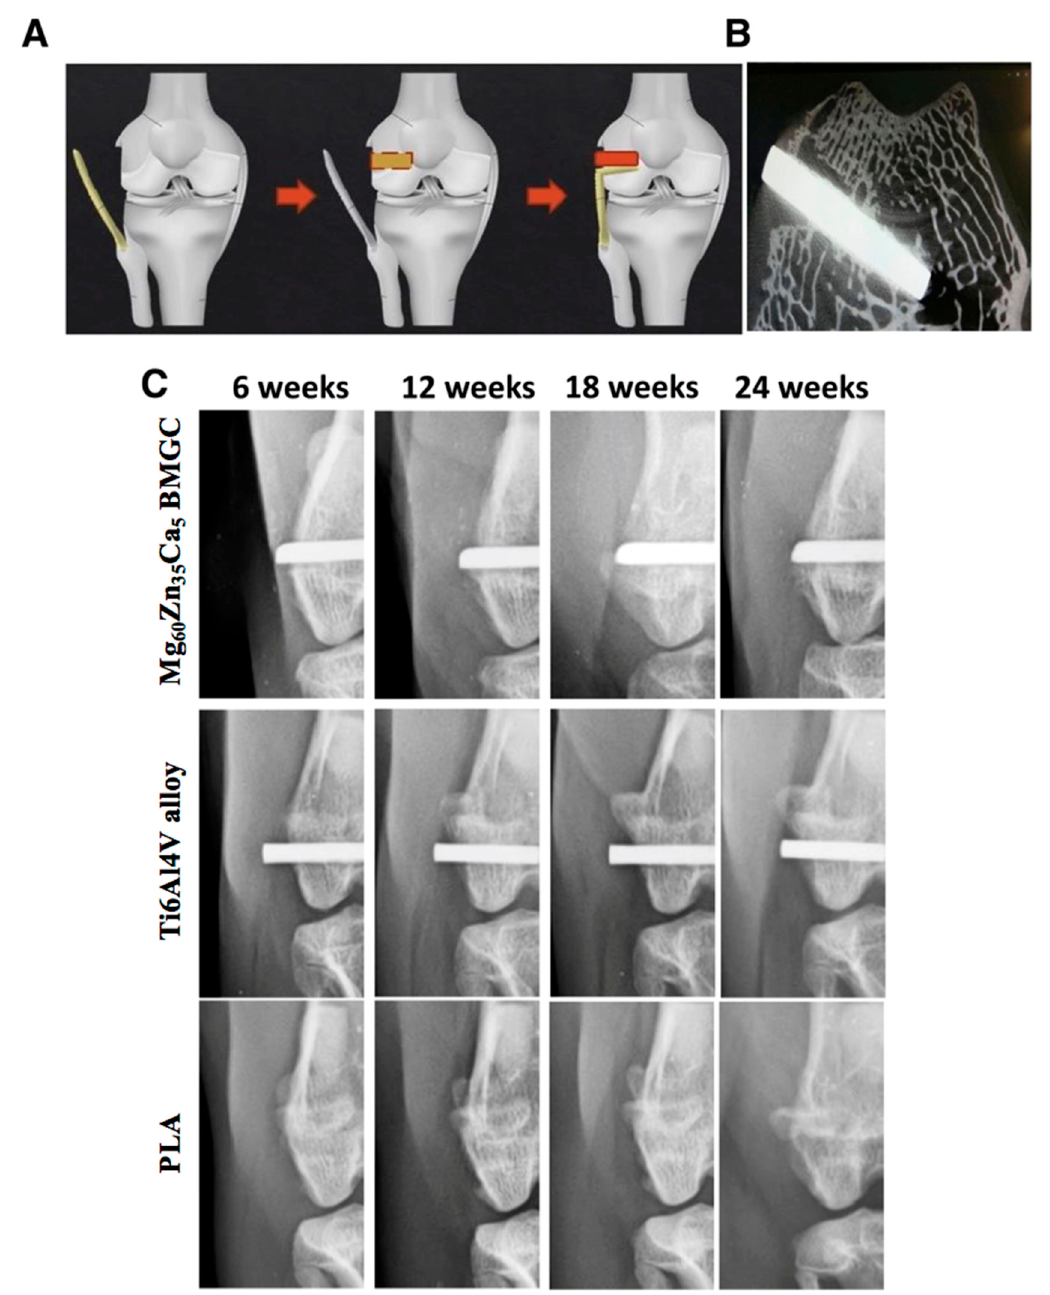
Figure 6. ( A ) Figure illustration of rabbit femur tendon-bone interference fixation model. First, lateral collateral ligament was detached from its femoral attachment. A 2.4 mm drill was used to create a bone tunnel which was 10 mm in length. Then, the tendon was fixed into the bone tunnel and secured with a rod acting as an interference implant. ( B ) Axial micro-CT image showing an implanted rod resided inside the bone tunnel. ( C ) Radiographic images of the rabbit’s femur implanted with either Mg 60 Zn 35 Ca 5 BMGC, Ti6Al4V alloy, or PLA materials at different time points.